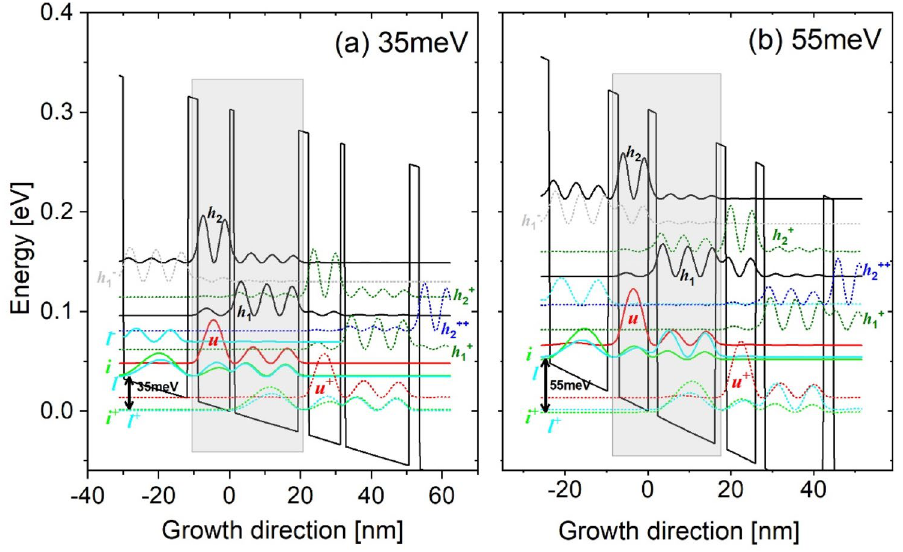
Figure 6. The pre-alignment condition where the injector level i aligns with level l , ( a ) 35 meV design; ( b ) 55 meV design.